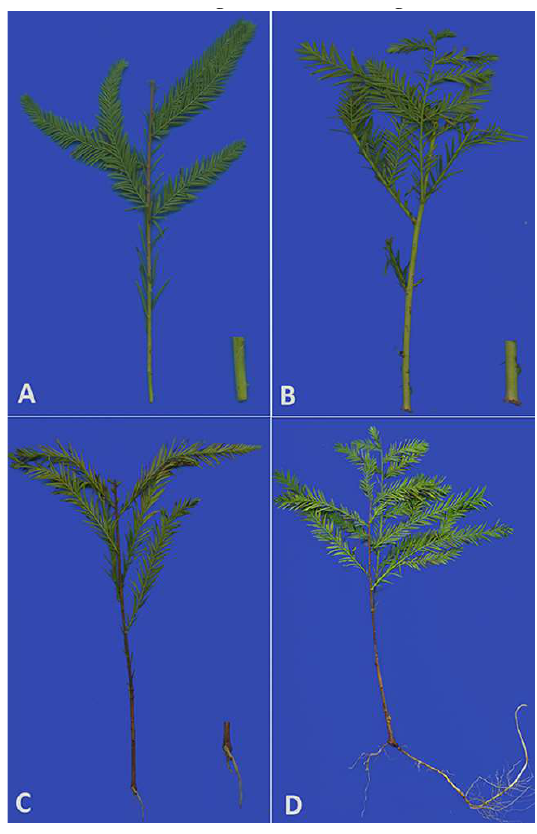
Figure 1. Adventitious root formation in T. ‘Zhongshanshan 406’ at different developmental time points: ( A ) dormant cortex period (S0); ( B ) the initial formation of calli (S1); ( C ) the formation of the primary root (S2); and ( D ) the root-elongation period (S3).